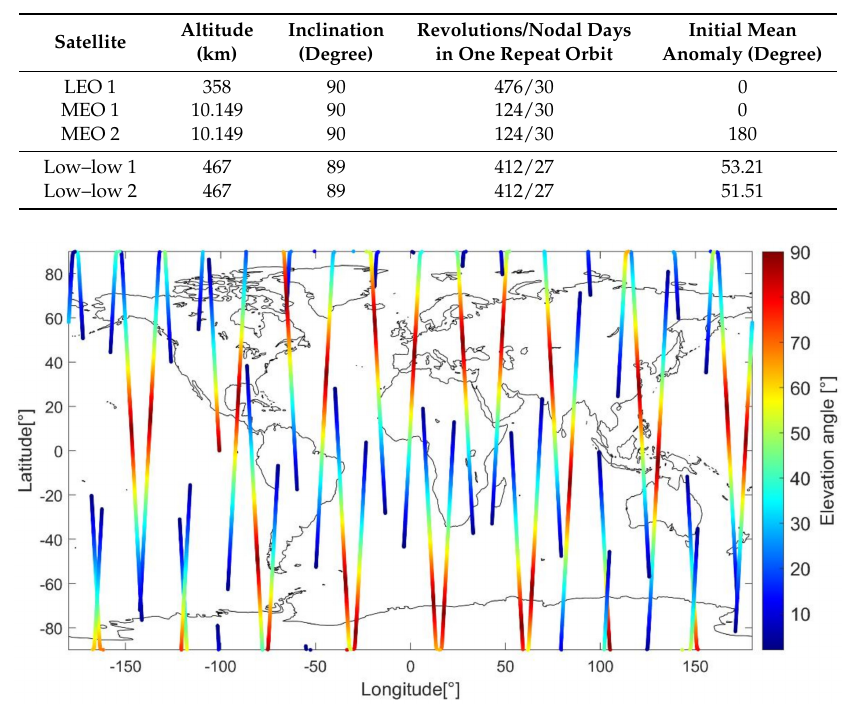
Figure 2. One-day LEO ground track of the MOBILE mission constellation together with the elevation angle of visible MEOs observed by the